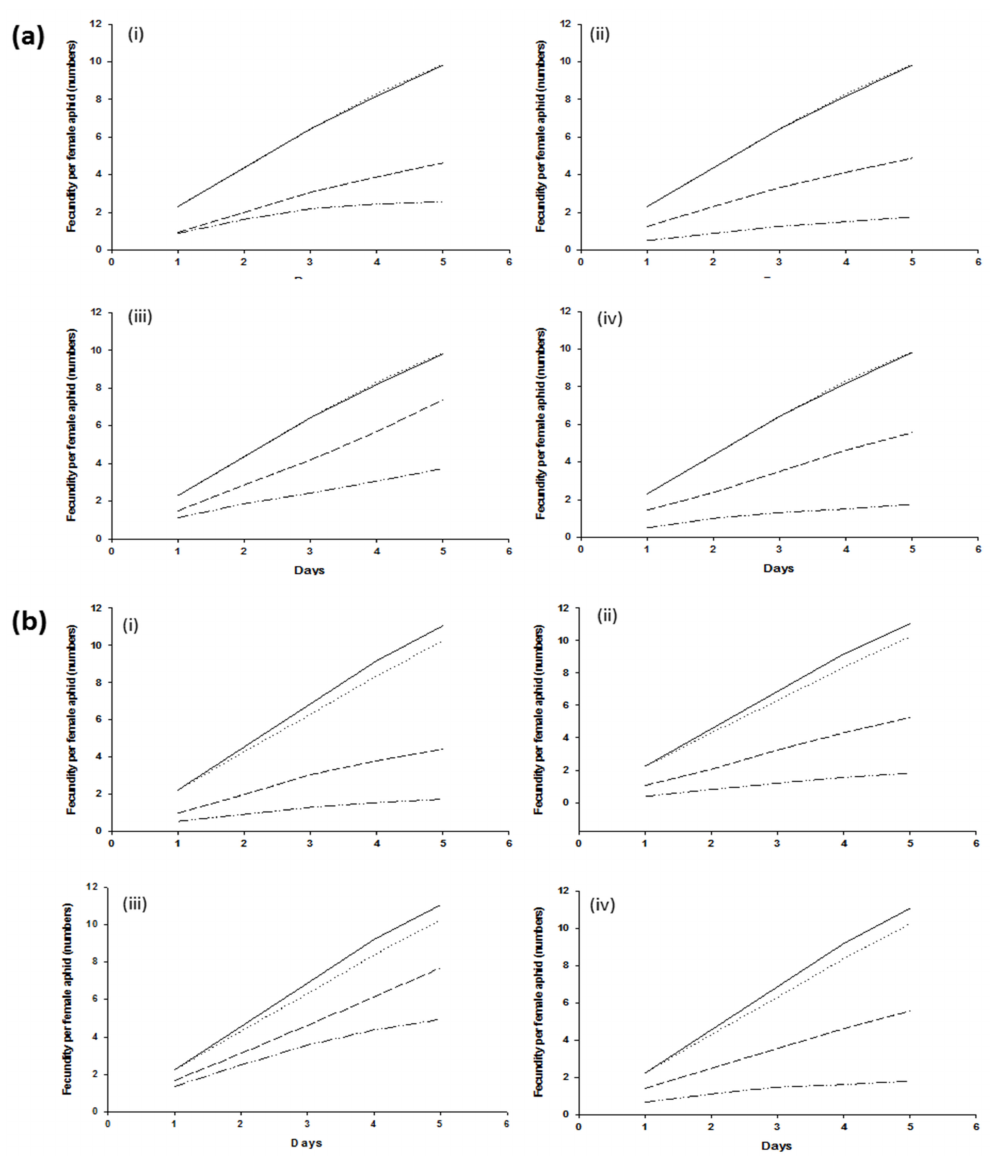
Figure 2. Number of offspring produced within 5 days following applications of entomopathogenic fungi Beauveria bassiana strains Bb1022 (i) and EABb04/01-Tip (ii) and Metarhizium brunneum strains ART 2825 (iii) and BIPESCO 5 (iv) to wheat aphid ( Sitobion avenae ) clones +5 and − 5 ( a ) and clones +7 and − 7 ( b ). ( ) shows control with BSS, ( ) shows control without BSS, ( ) shows treatment with BSS, and ( ) shows treatment without